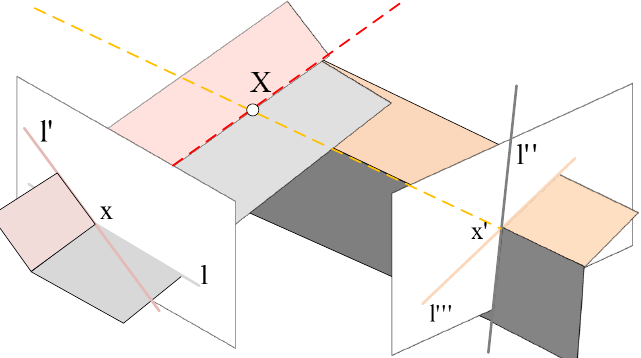
Figure 4. Illustration of the geometrical property of LSVI matching points. There are two pairs of matched line segments on two images (represented by different colors) and four planes determined by these four line segments in space (represented by different colors). X represents the 3D point intersected by these four